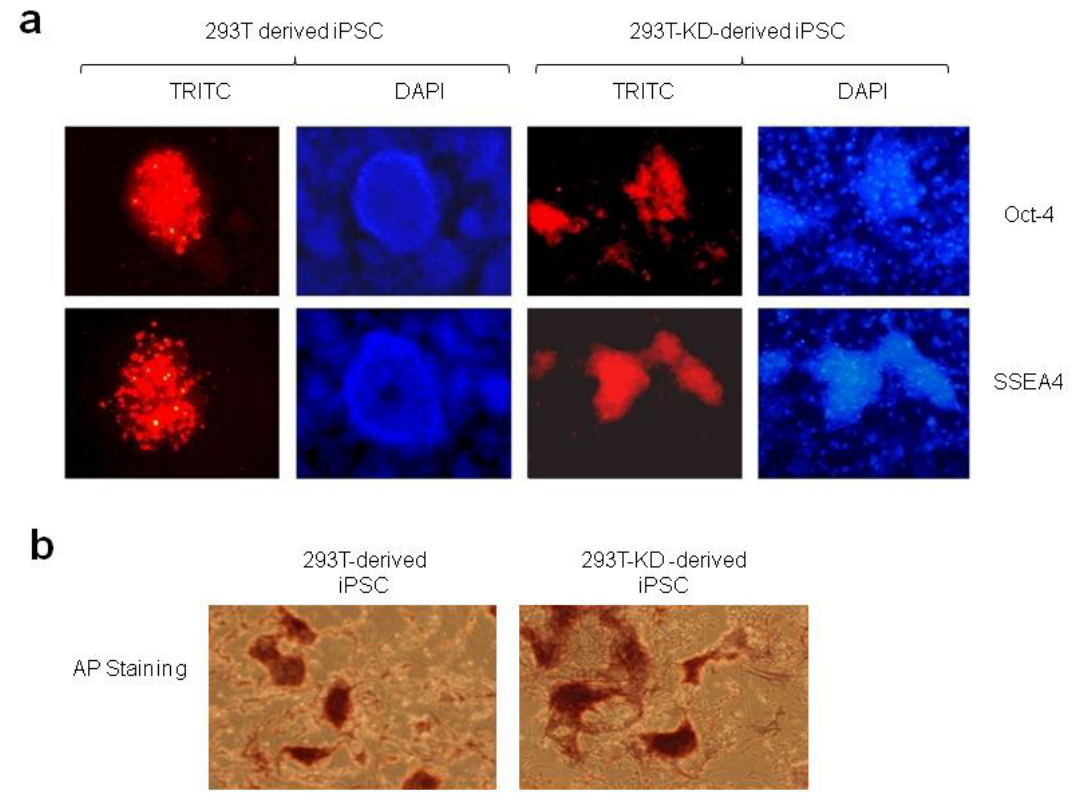
Figure 3. Characterization of iPSC colonies. ( a ) Immunofluorescence staining of ES markers. Oct-4 and SSEA4 markers staining in iPSC derived from 293T and 293T-KD cells, red fluorescence. DAPI staining is shown in blue fluorescence. Magnification-200×. ( b ) AP positive staining of 293T derived iPSC colonies. AP positive staining (red color) is shown for 293T and 293T-KD derived iPSC